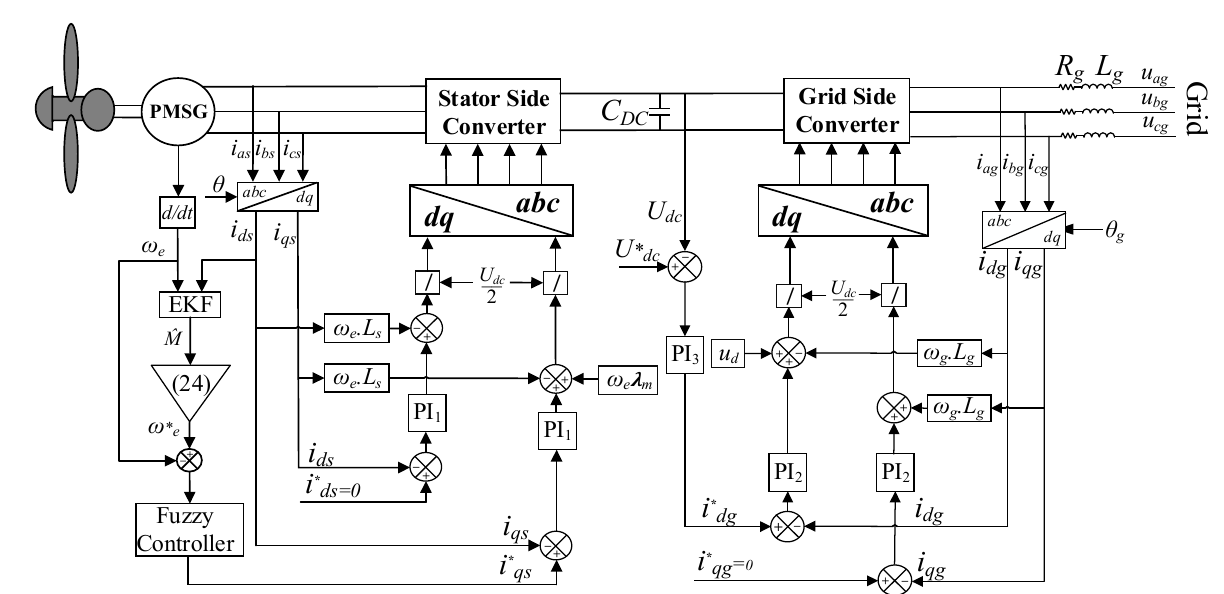
Figure 8. Proposed PMSG structure and control method. Table 6. Parameters of the proposed system.